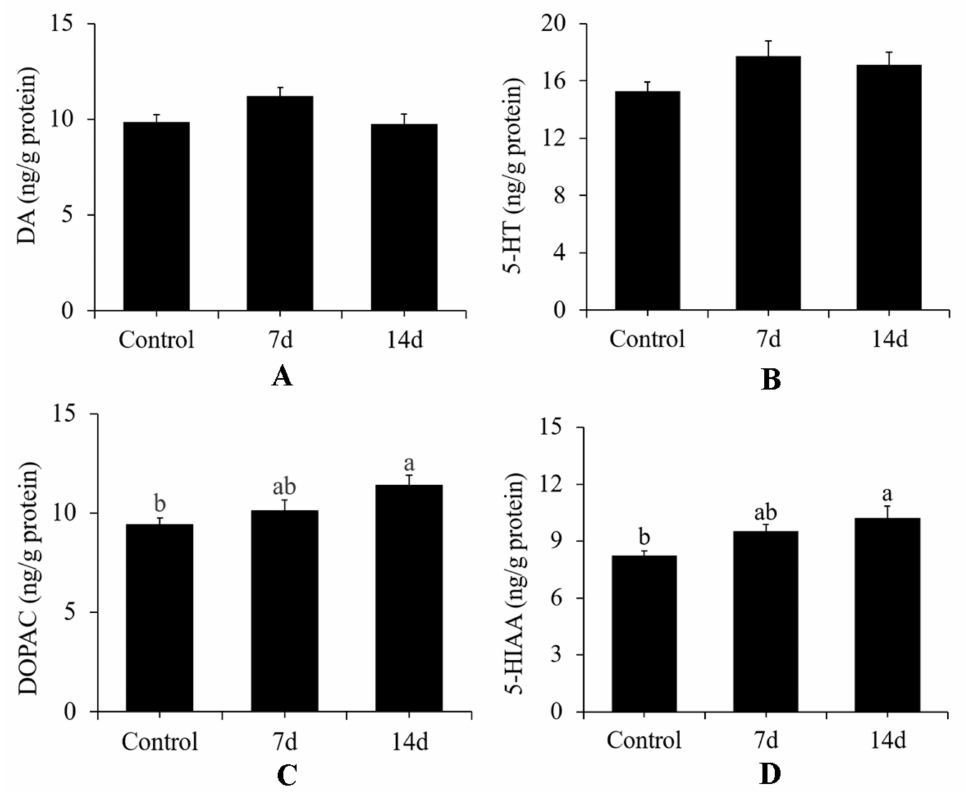
Figure 10. Effects of 7 and 14 days of the UCS protocol on neurotransmitter levels in rare min- now. ( A ) DA, ( B ) 5-HT, ( C ) DOPAC, and ( D ) 5-HIAA. Data are expressed as mean ± SD (n = 3). Three pooled samples of four fish each from each treatment. The different letters in the bar indicate significant differences between the two groups ( p <